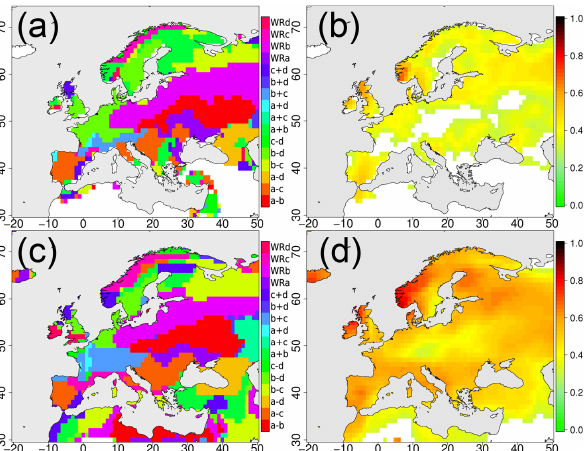
Figure 9. Assigned winter WR (a) and associated absolute corre- lation values (b) for the optimized forecast (i.e. predictors defined using MOAWRs from ENS and observed SPI-1). Panels (c) and (d) are the same as (a) and (b) for the process forecast (i.e. predictors defined using MOAWRs from ENS and forecasted